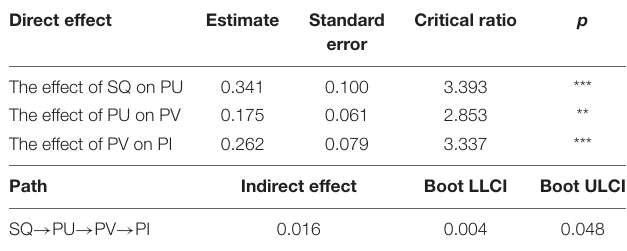
TABLE 8 | Results of path analysis 8.